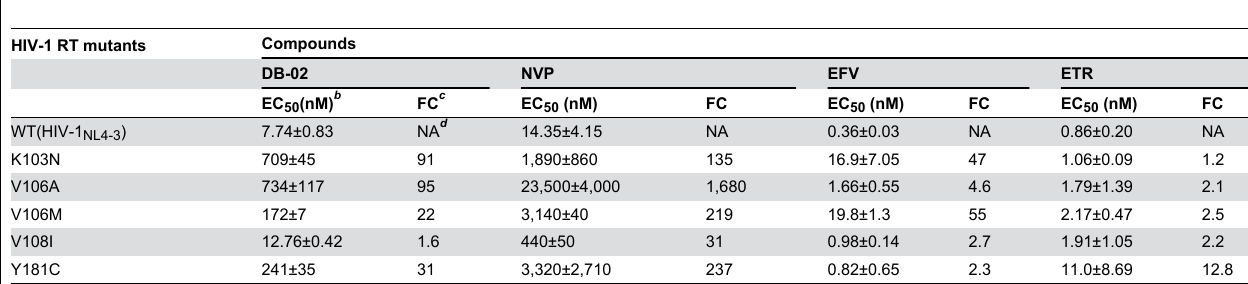
Table 2. Anti-HIV-1 activity of DB-02 against site-directed mutation viruses a